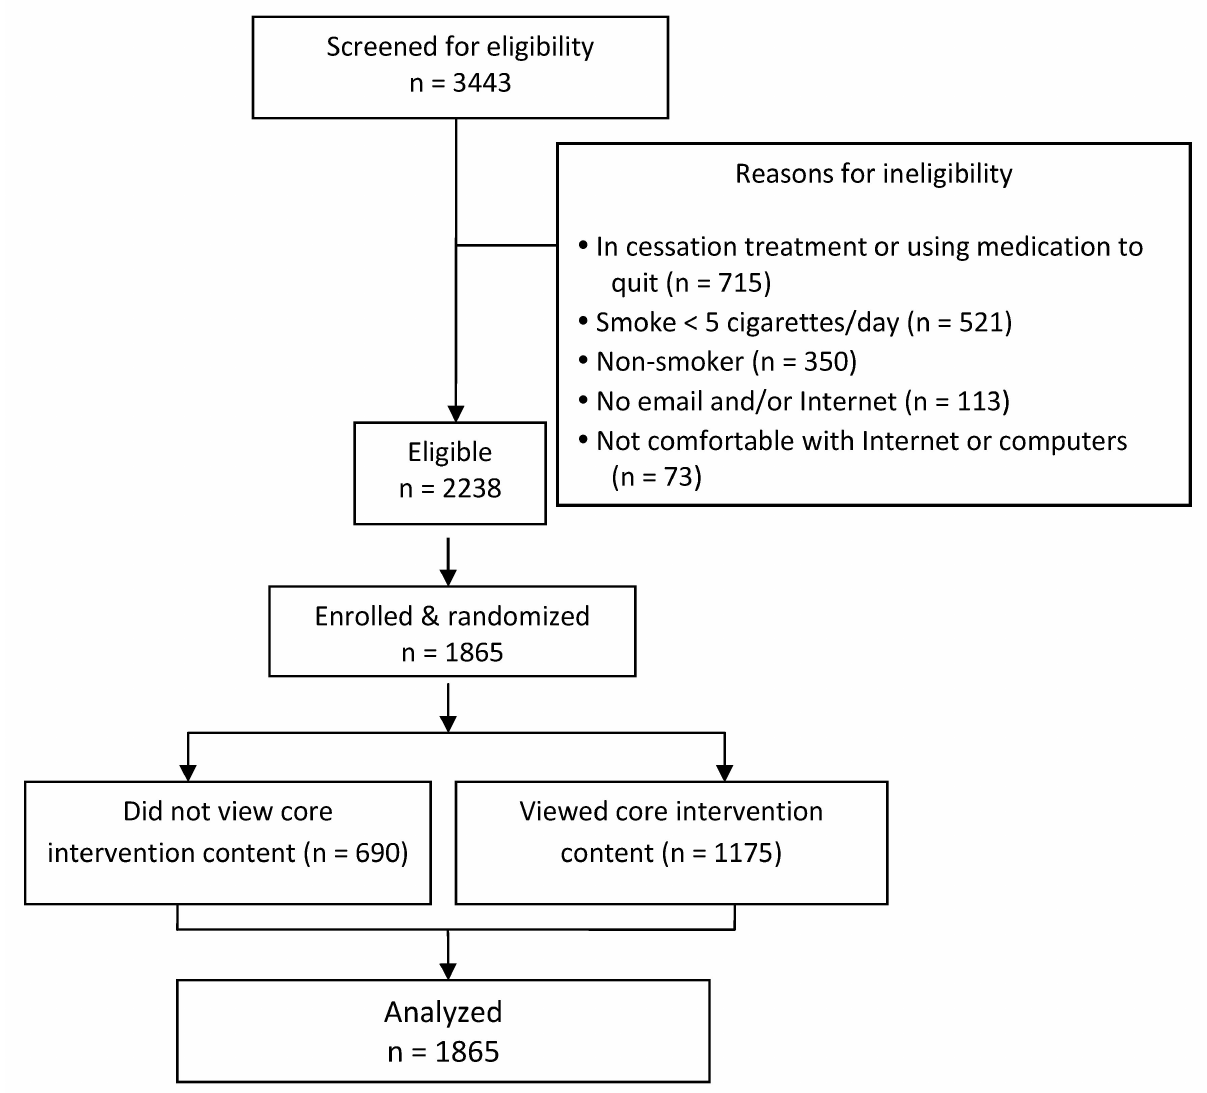
Figure 2. Recruitment flow and allocation of